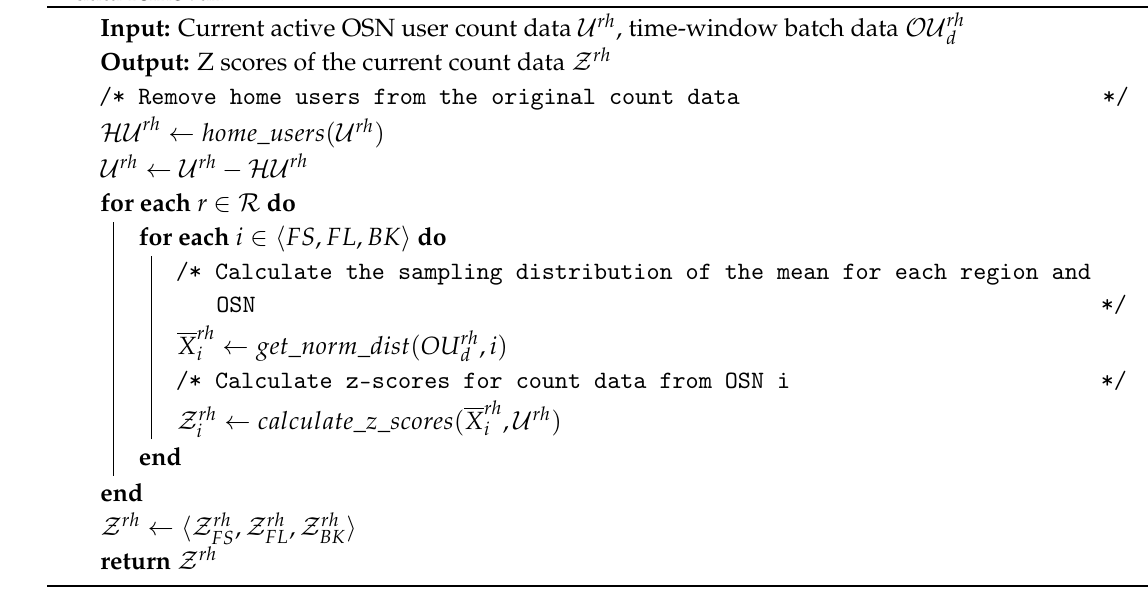
Algorithm 1: Pseudo-code of the Z-scores calculation for OSN count data, including home-user data